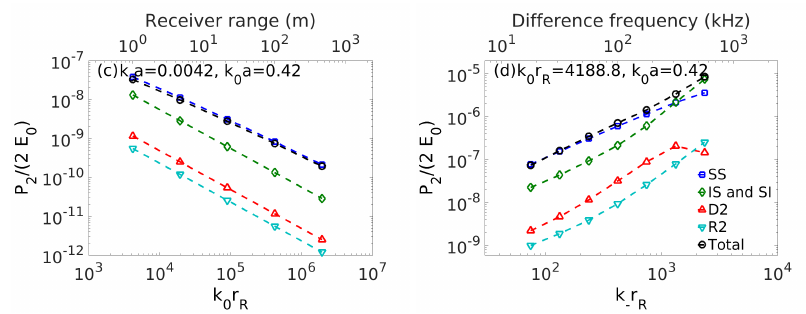
Figure 4. A rigid movable sphere with collinear incident waves propagating at ˆ i z . The difference frequency component of p 2 is calculated at r R = − r R ˆ i z as a function of ( a ) center frequency or k 0 a , ( b ) object radius or k − a , ( c ) receiver range or k 0 r R and ( d ) difference frequency or k − r R . In ( a ), p SS dominates for large k 0 a , while p D2 dominates for small k 0 a . In ( b ), p SS dominates for large k − a and p D2 dominates for small k − a . In ( c ), p SS is dominant has the most gradual roll-off with range. In ( d ), p SS dominates for small k − r R and p IS + p SI dominates for large k − r R . The nonlinear parameter is β = 3.6, and the density ratio between the object and medium is 7.6. Lower dimensionless abscissas are for general interpretations. Upper abscissas are for a medical or underwater sensing example as in Figure 3, except the rigid object is movable.